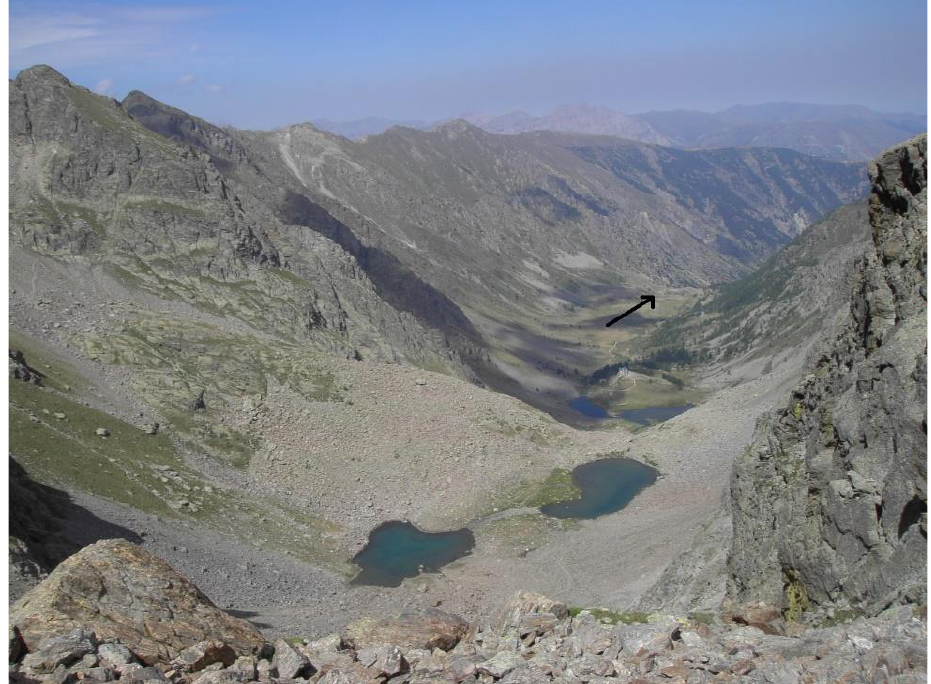
Figure 4. A bird’s -eye down-valley view of the Ischiator catchment, upper part: typical U-shaped Figure 4. A bird’s-eye down-valley view of the Ischiator catchment, upper part: typical U-shaped slopes owing to the glacial activity. slopes owing to the glacial